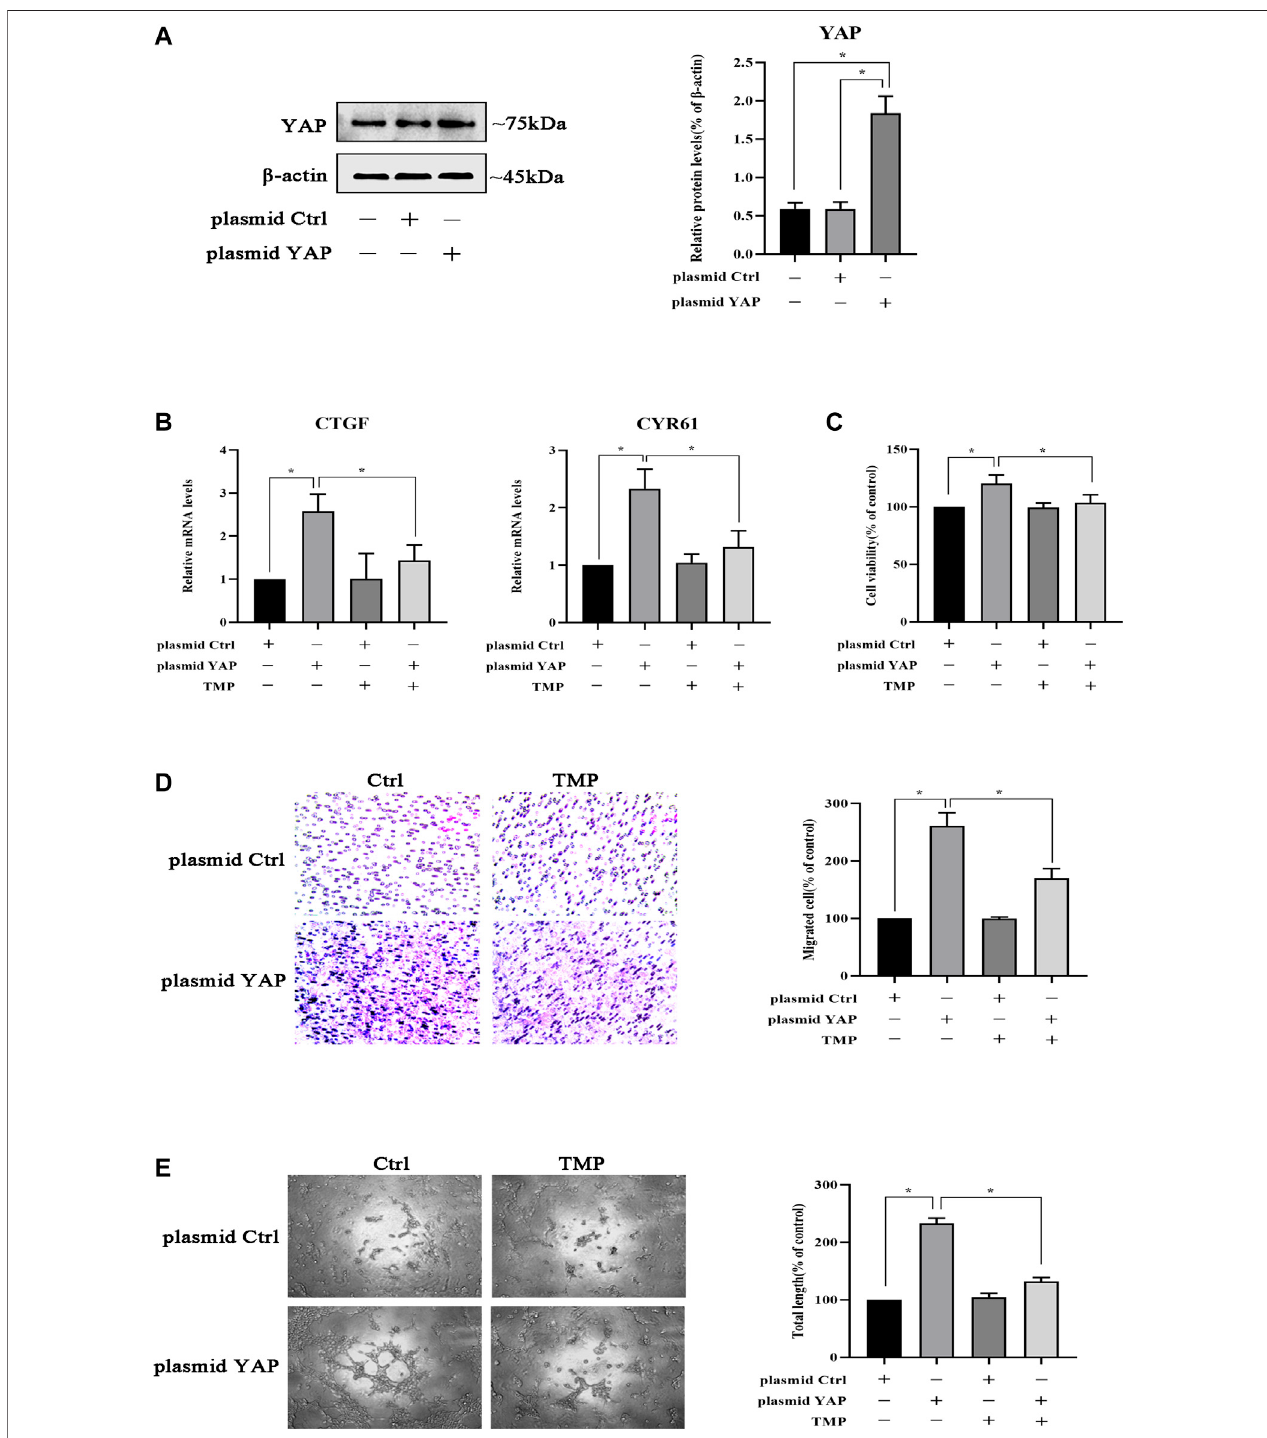
FIGURE 7 | TMP inhibits HPVEC migration and tube formation by targeting YAP. (A) HPVECs were transiently transfected with the control plasmid and the overexpression YAP plasmid for 48 h. Then western blotting was used to detect YAP protein expression. (B – E) HPVECs were transiently transfected with the control plasmidand theoverexpressionYAP plasmidfor48 h andsubsequentlytreatedwithTMP(40 μ M). (B) HPVECswerelysed usingtheTRIzolreagentand thensubjected to real-time PCR to measure mRNA levels of CTGF and CYR61. (C) Cell proliferation was detected by CCK-8 assay. (D) Migration of HPVECs was detected by transwell migration assay. (E) Tube formation was quanti fi ed by counting the total length in three randomly selected fi elds of view. Data are expressed as mean ± SEM (* p < 0.05).